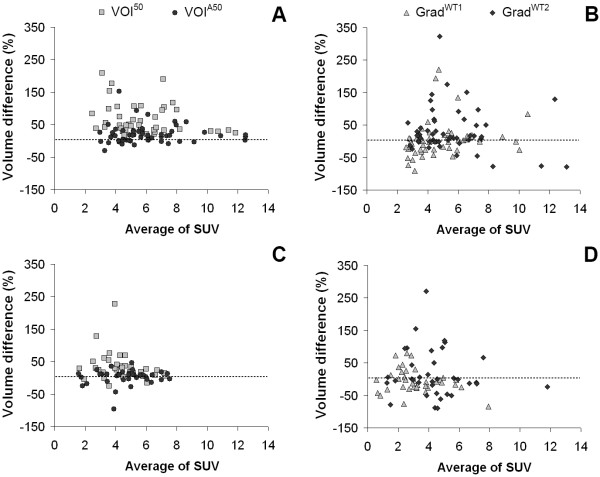
Percentage difference in measured volumes compared to SUV. Percentage difference in measured volumes compared to SUV derived from SUV and Patlak images for various delineation methods applied to (A, B) NSCLC and (C, D) GI cancer. Note that some data points (for VOI50 and GradWT2) fall outside the range of the figure. The percentage difference was defined as VolumeSUVVolumePatlak - 1×100%.